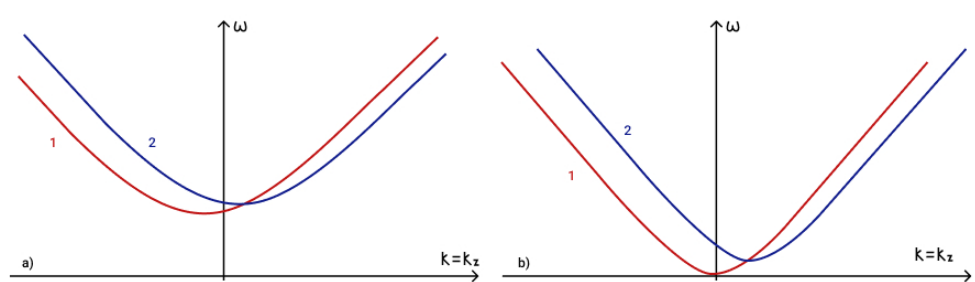
) + ω ( k z ) ; ( b ) three waves with frequency z 1 c c ) + ω ( k z ) z 2 c c